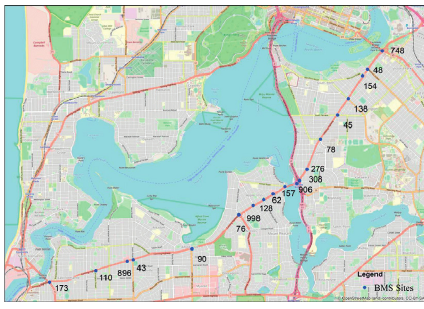
Figure 1: Canning